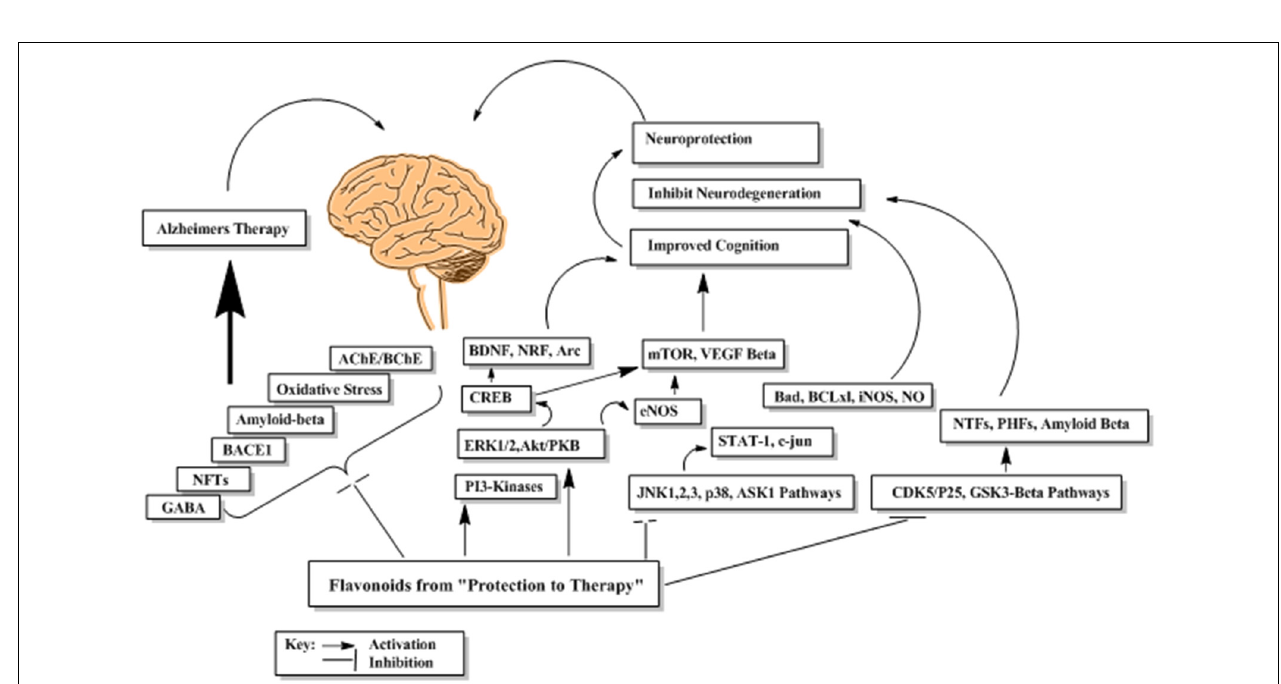
FIGURE 13 | The probable abridged mechanism of flavonoids in enhancing cognition and suppression of neurodegeneration.